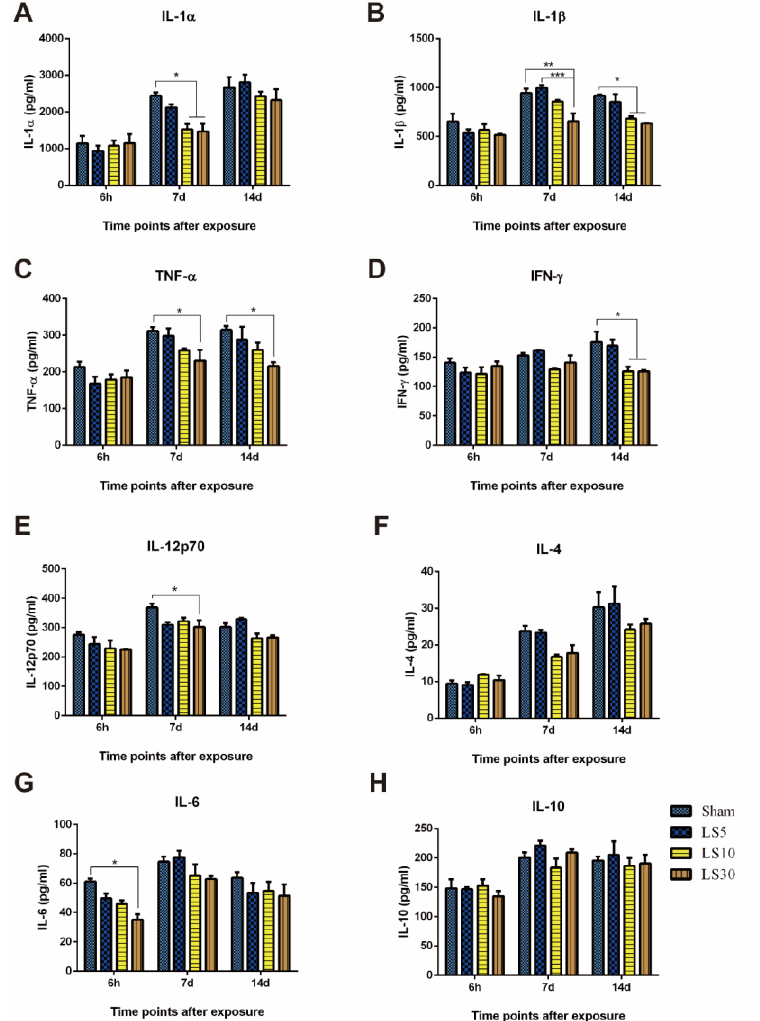
Figure 3. Multifrequency microwave exposure decreased the levels of Th1 cytokines in peripheral blood. Wistar rats were exposed to multifrequency microwaves at average power densities of 5, 10, and 30 mW/cm 2 . At 6 h, 7 d, and 14 d after exposure, peripheral blood was collected, and serum was separated by centrifugation. The levels of interleukin (IL)-1 α ( A ), IL-1 β ( B ), tumor necrosis factor α (TNF- α ) ( C ), interferon γ (IFN- γ ) ( D ), IL-12p70 ( E ), IL-4 ( F ), IL-6 ( G ), and IL-10 ( H ) were analyzed by Cytokine & Chemokine 22-Plex Rat ProcartaPlex Panel using flow cytometry. Data are shown as the mean±s.e.m., * p < 0.05, ** p < 0.01, *** p < 0.001, vs. corresponding groups.